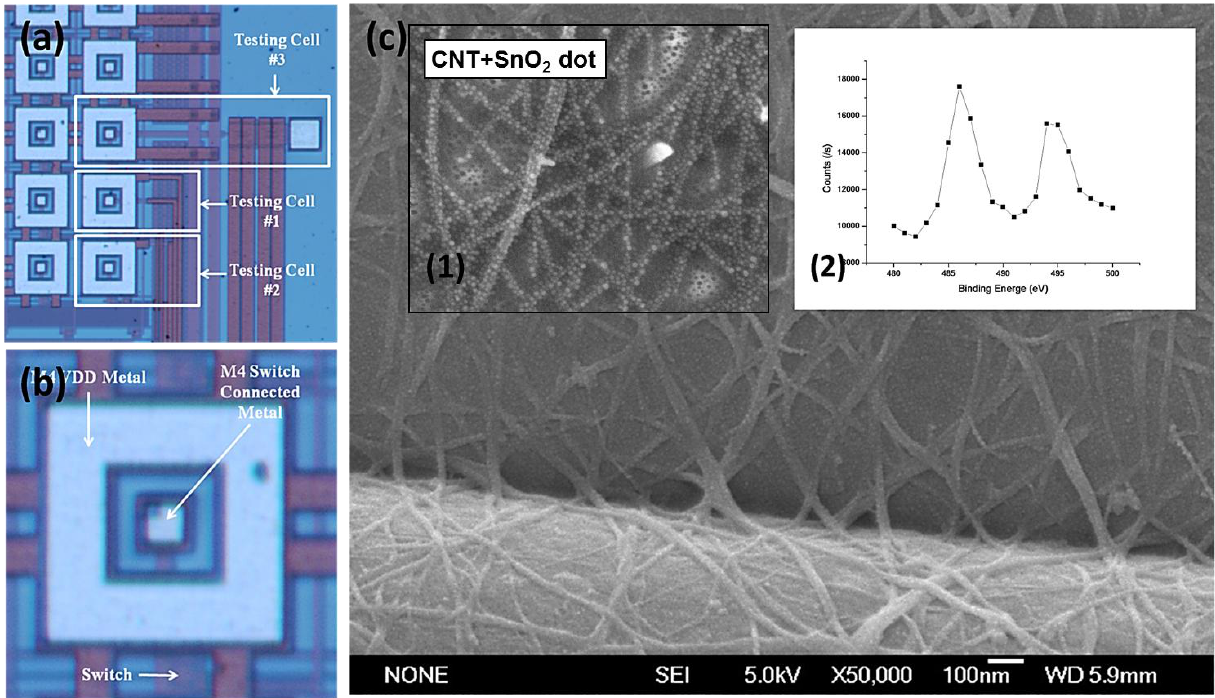
Figure 1. CNT sensing cell information. ( a ) Optical image of CNT test cells. ( b ) Individual CNT cell. ( c ) SEM image of the SnO -decorated CNT network. ( c.1 ) SEM image of the 2 SnO -decorated CNT network at higher magnification. ( c.2 ) Core-level XPS Sn3d 2 spectrum indicating oxidation of the